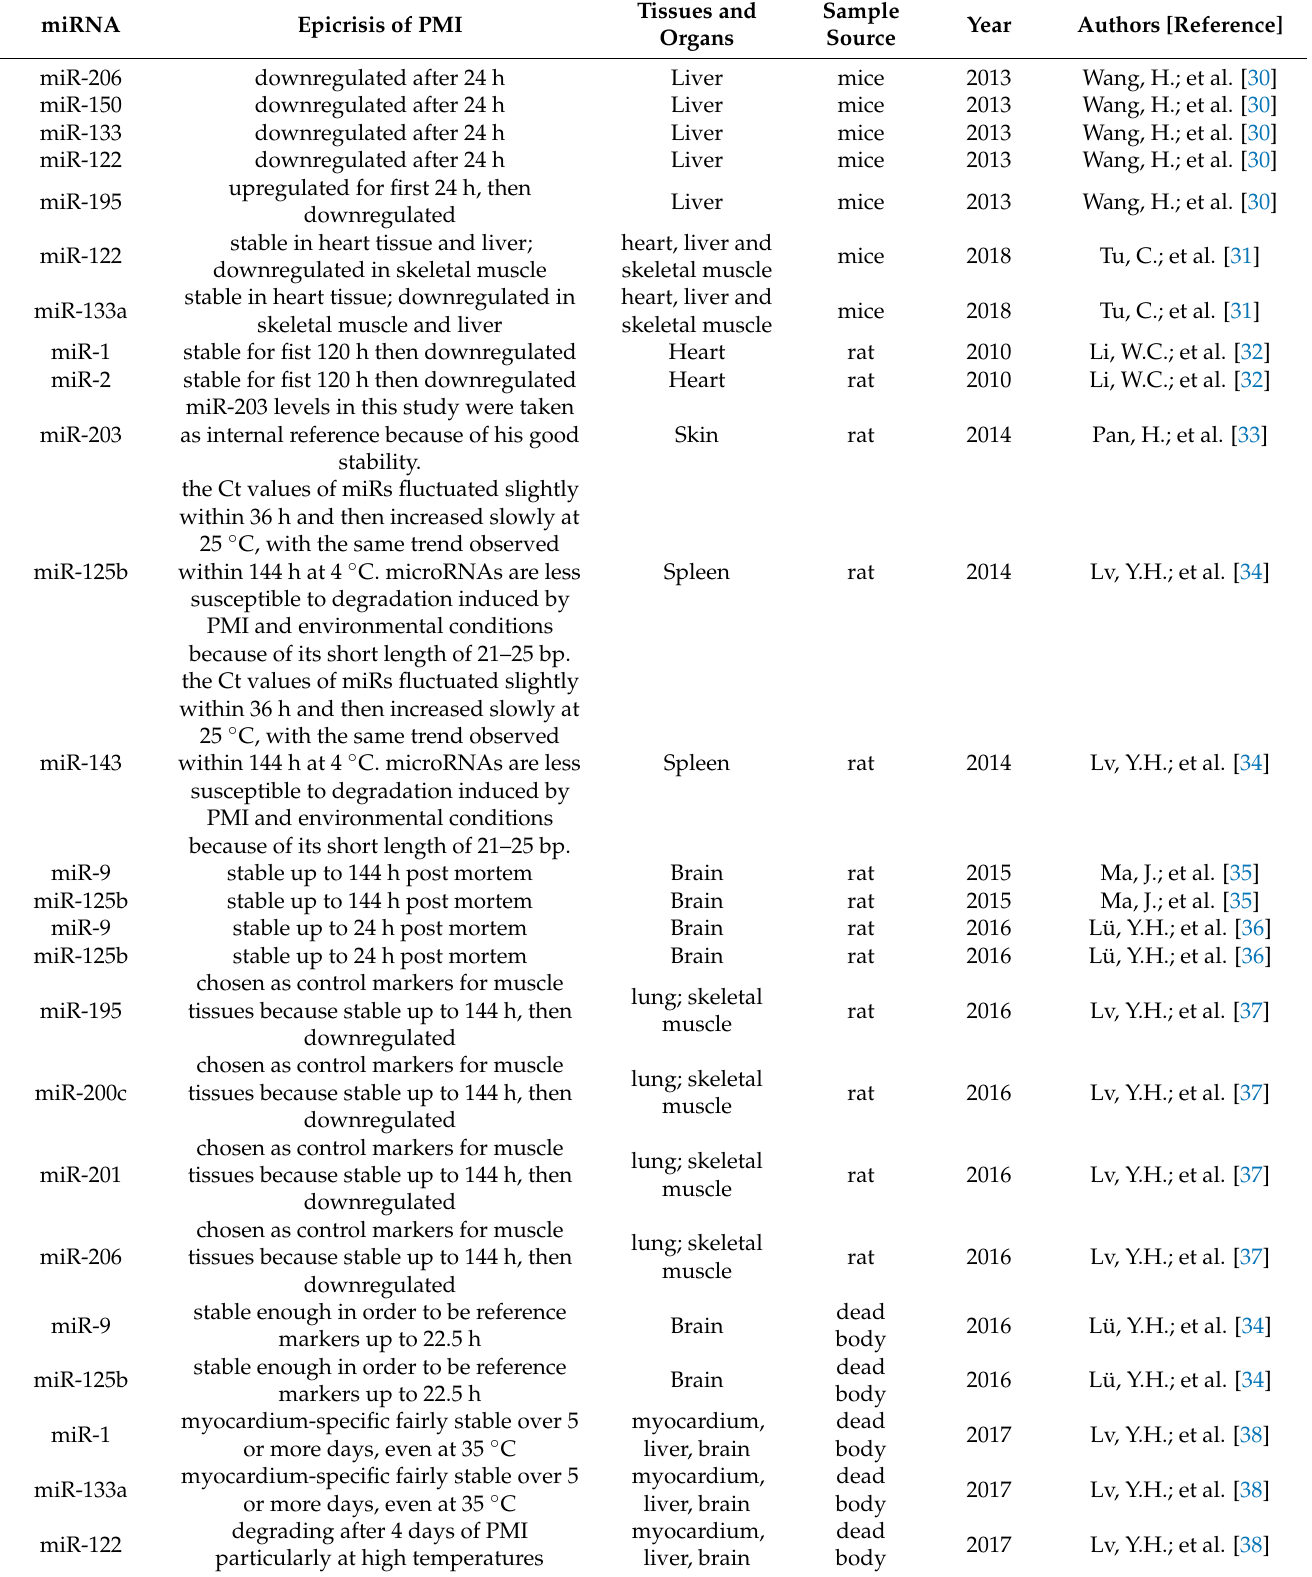
Table 1. Summary of the literature, including extracted